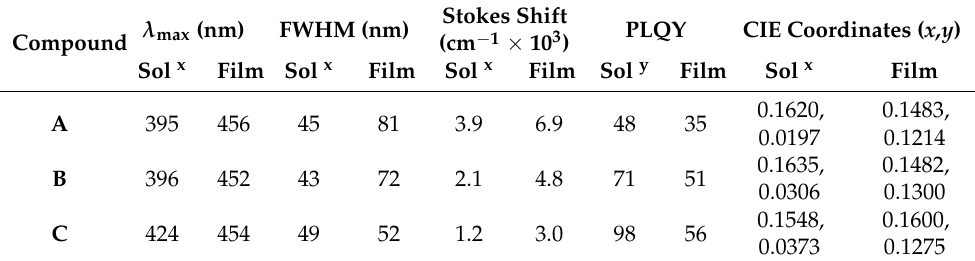
Table 2. Summary of emission properties of compounds A , B , and C .